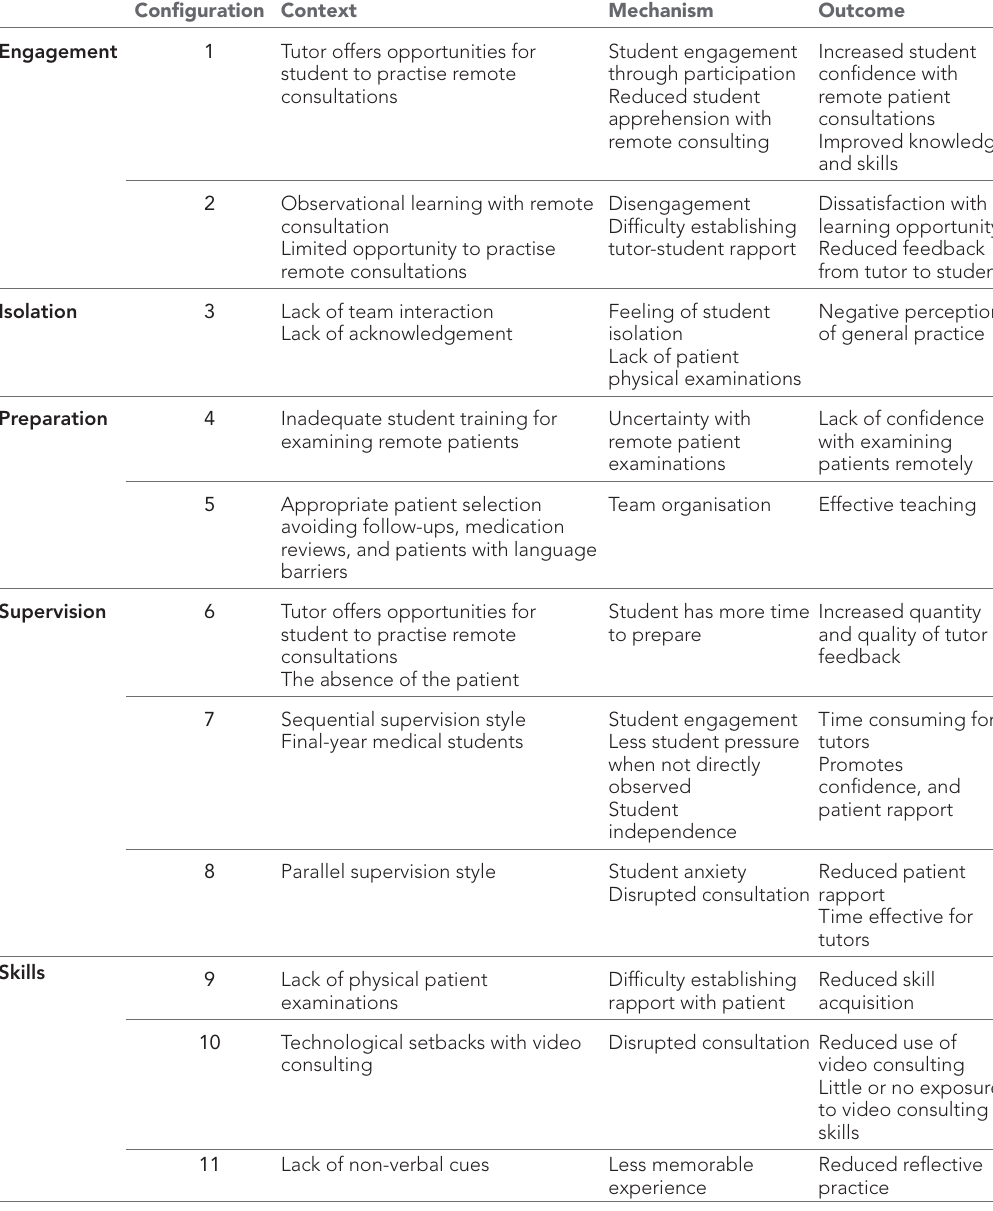
Table 3 The context–mechanism–outcome configurations for the study Configuration